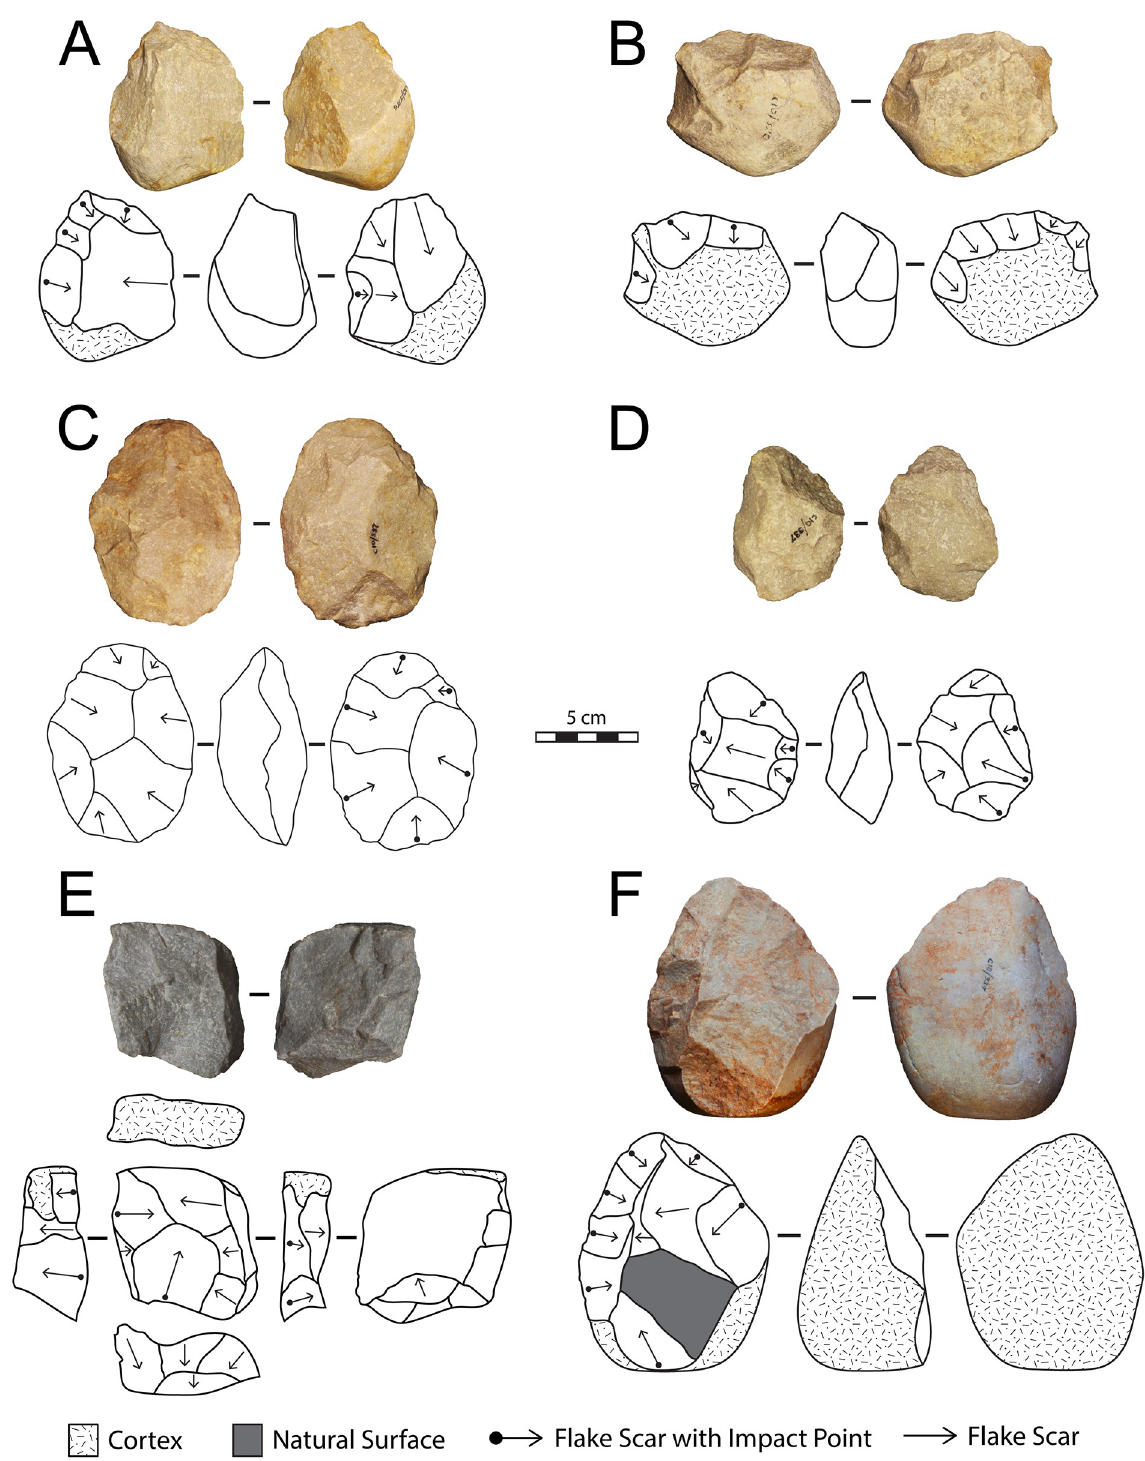
Fig 14. Examples of small debitage core from Area 1. A) Bifacial Alternate; B) Bifacial Continuous; C) Discoidal Continuous; D) Discoidal Alternate; E) Prepared; F) Unifacial.